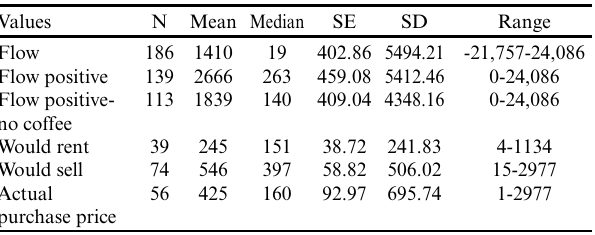
Table 3 . Net returns US$ ha -1 with the flow and rent approaches. Flow estimates are per land use and include forest zeros; all rent values included once, no matter how many land uses per plot; mean, median, minimum, and maximum rounded to zero decimals to enhance clarity.